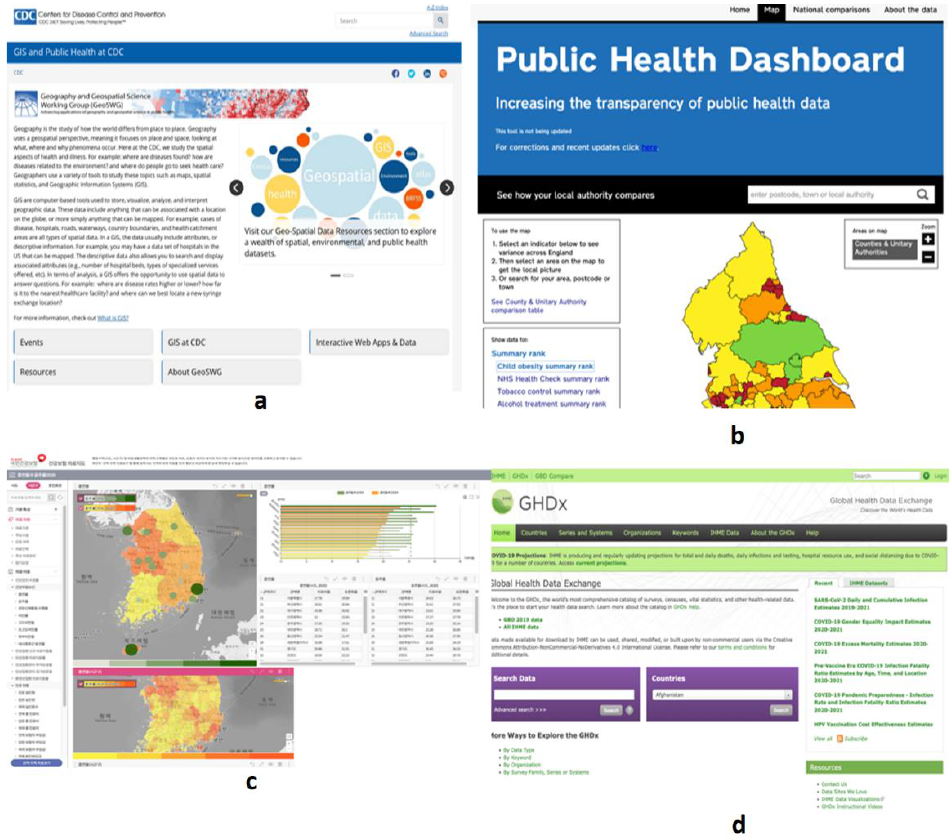
Figure 3. Examples of health SDIs: ( a ) the Geography and geospatial science working group (GeoSWG) at the U.S. Centers for Disease Control and Prevention; ( b ) Public Health England’s Public Health Dashboard; ( c ) Korea National Health Insurance Service-ATLAS; ( d ) the University of Washington’s Institute for Health Metrics and Evaluation [62–65]. Another noteworthy example not shown in this figure is the ‘World Health Organization (WHO) GIS Centre for Health’ portal, which is publicly accessible online.